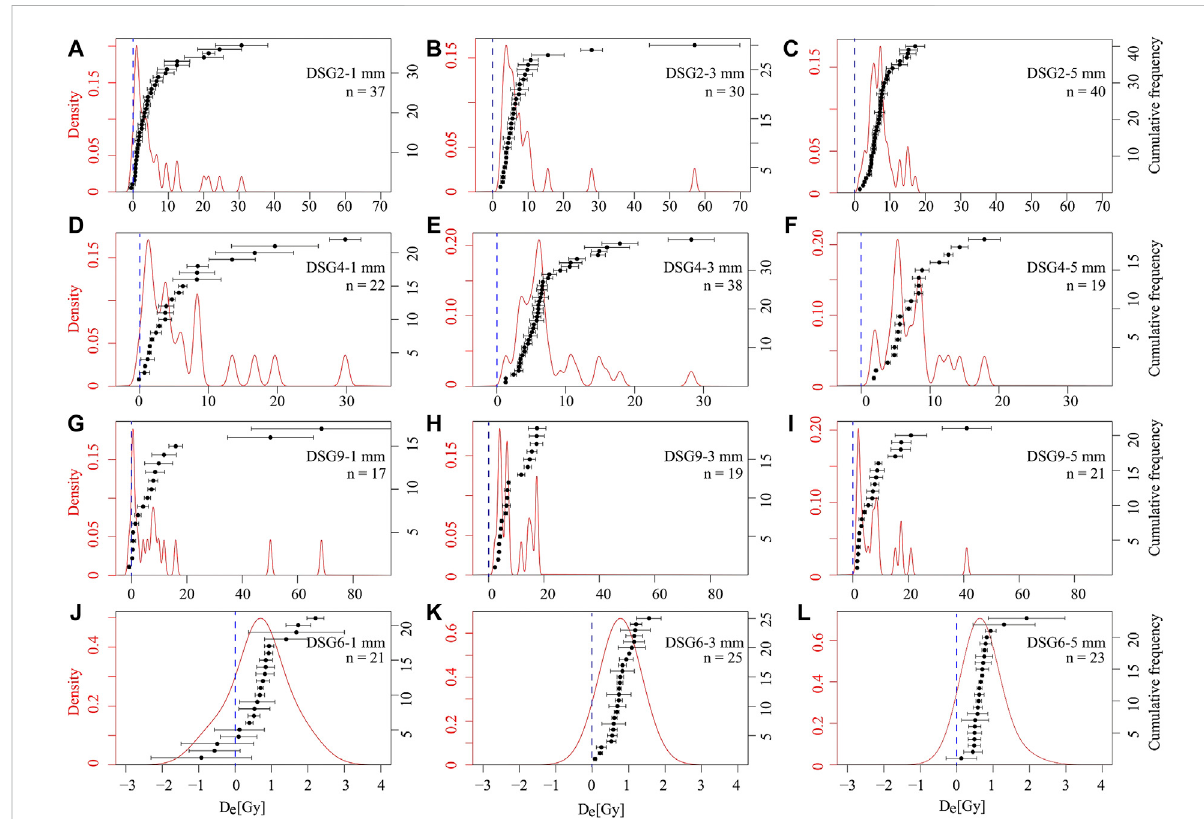
FIGURE 4 Kernel density estimate plots ofnaturaldosedistributions fromDSG2with 1-,3-,5-mmaliquots (A – C) ;DSG4 with1-,3-, 5-mm aliquots (D – F) ; DSG9 with 1-, 3-, 5-mm aliquots (G – I) and DSG6 with 1-, 3-, 5-mm aliquots (J – L) .